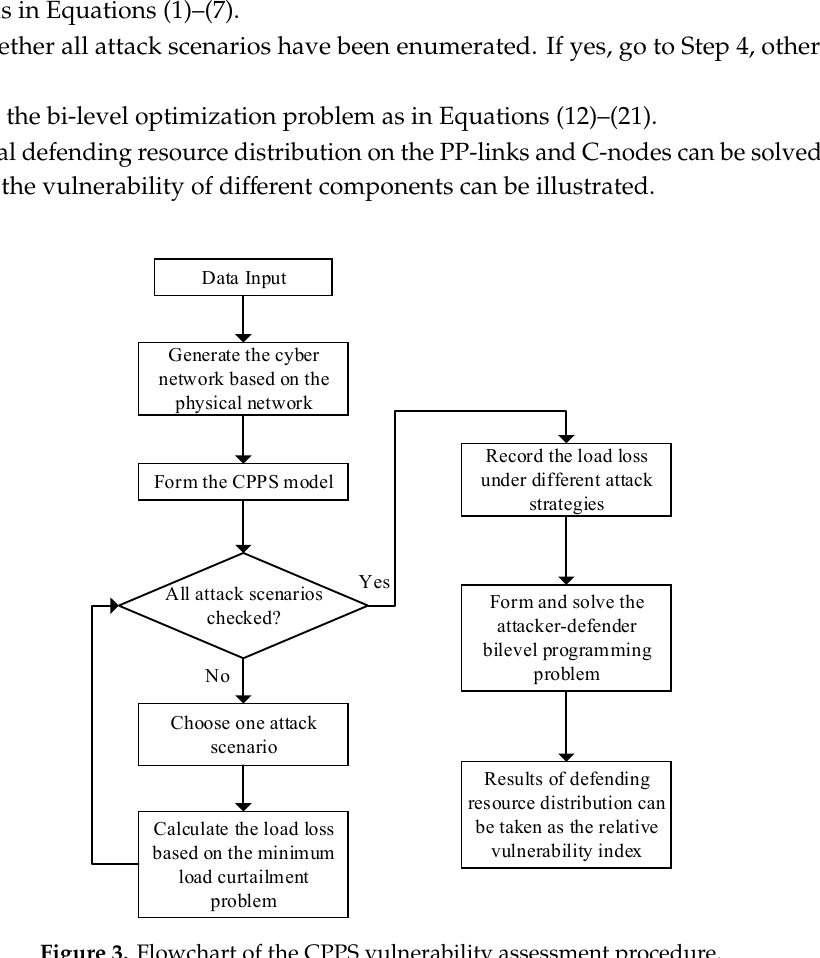
Figure 3. Flowchart of the CPPS vulnerability assessment procedure.